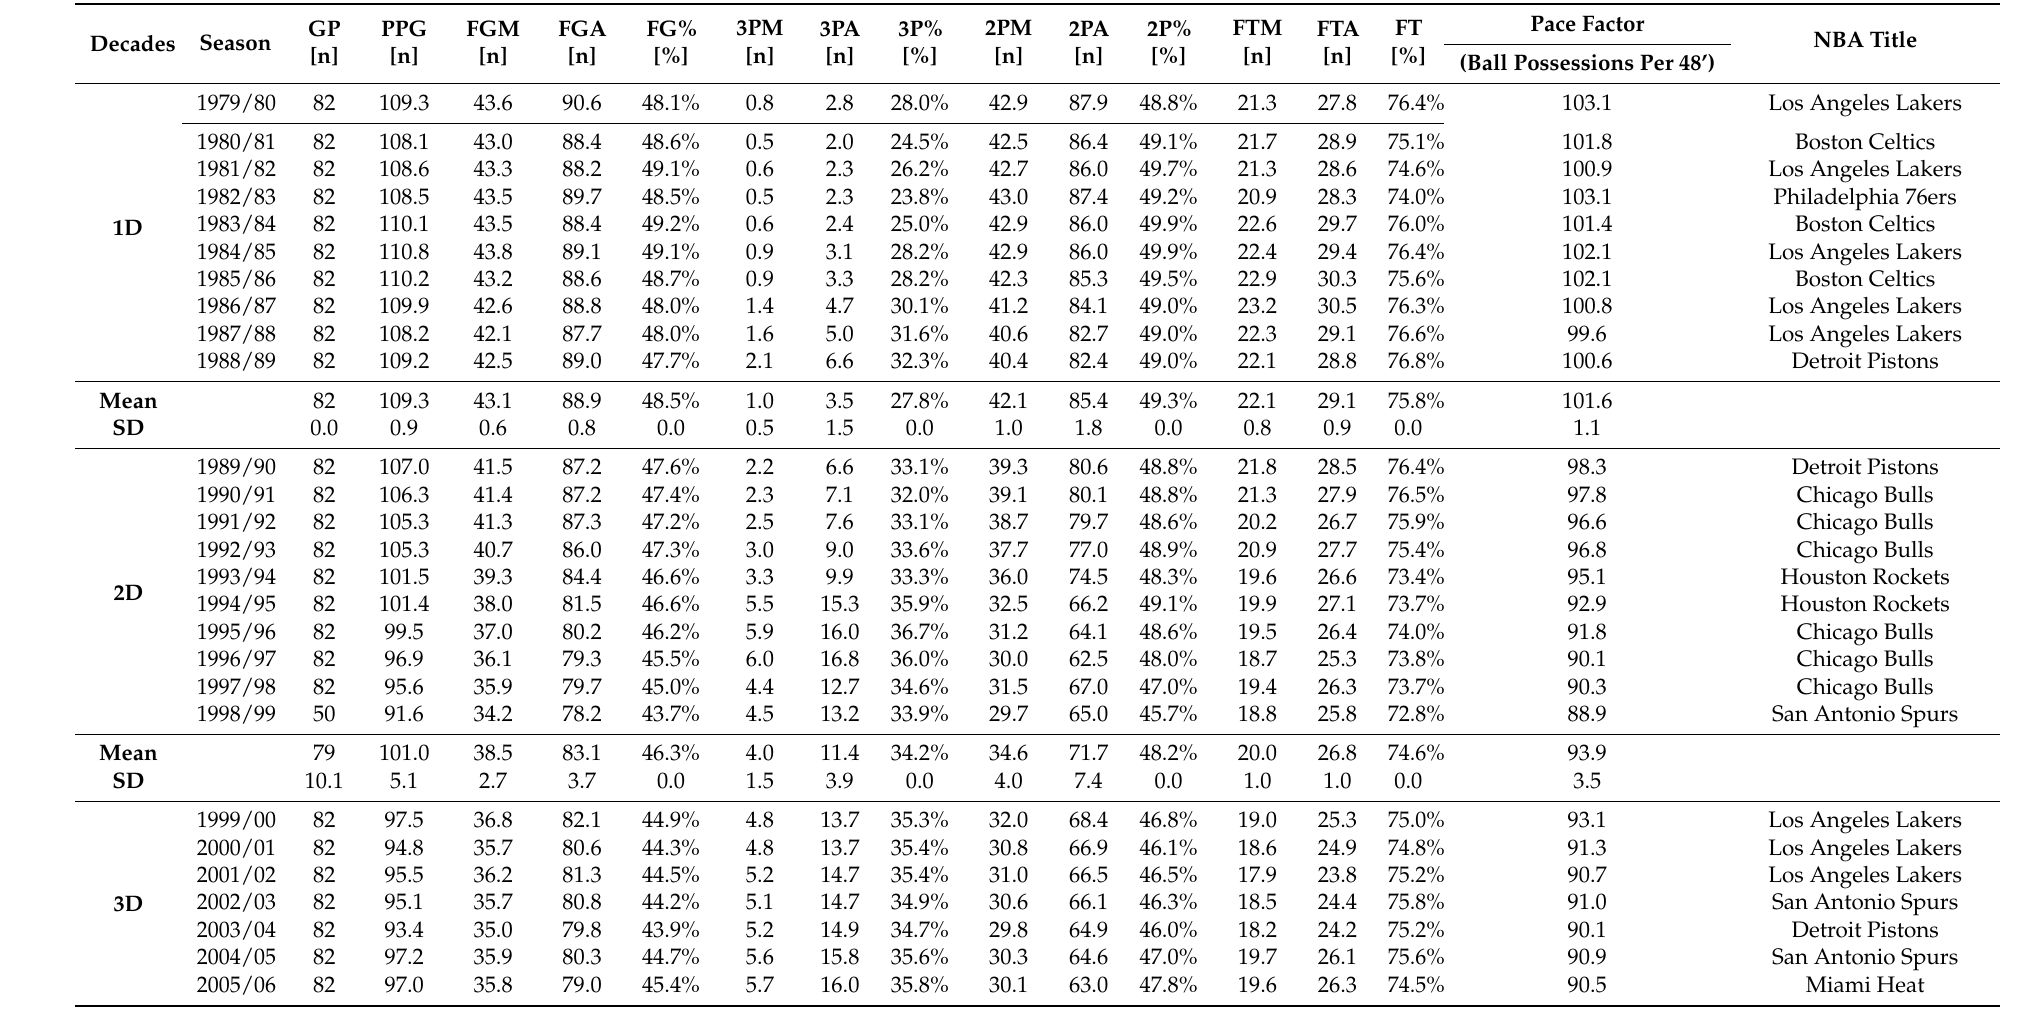
Table 1. Descriptive data of selected